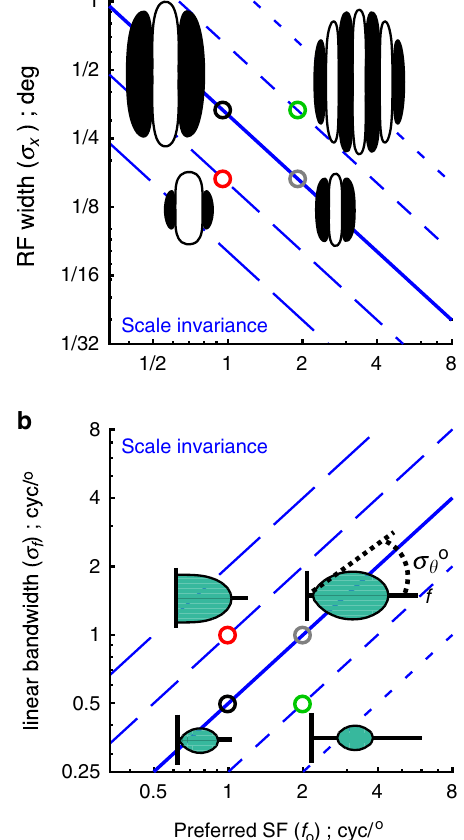
Fig. 1 Illustration of scale invariance. a RF width ( y -axis) is inversely proportional to f o ( x -axis) in a model of scale invariance. Points that are common to any of the fi ve blue diagonal lines are part of a scale invariant family. Four example Gabor ’ s are shown at the four locations indicated by open circles. Prior studies have typically modeled V1 RFs as sitting along the solid blue line (Eq. (1)). b SF bandwidth ( y -axis) is proportional to f o ( x -axis) in a model of scale invariance. Each location represents a 2D Gaussian that is constrained by the Fourier transform of the Gabors in a . Each blue line in b is calculated from the Fourier transform of the family of Gabor ’ s along each line of a . Also, the 2D Fourier transform of the four Gabors shown in a are overlayed, where the x -axis (cyc/°) is along the preferred orientation. The green ellipse indicates the distribution of 2D spectral energy. Along a line of scale invariance (e.g. solid blue), orientation bandwidth ( “ σ ϴ ” , top right) does not